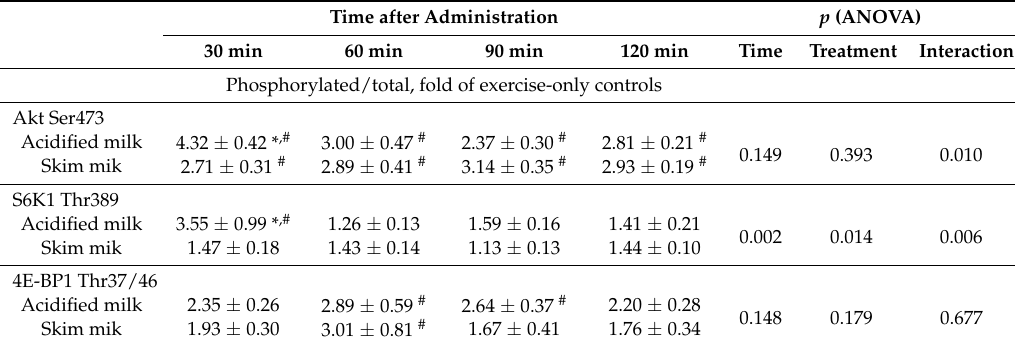
Table 2. Western blotting analyses of synthesis-associated signaling proteins in rats administered acidified milk or skim milk 1 .